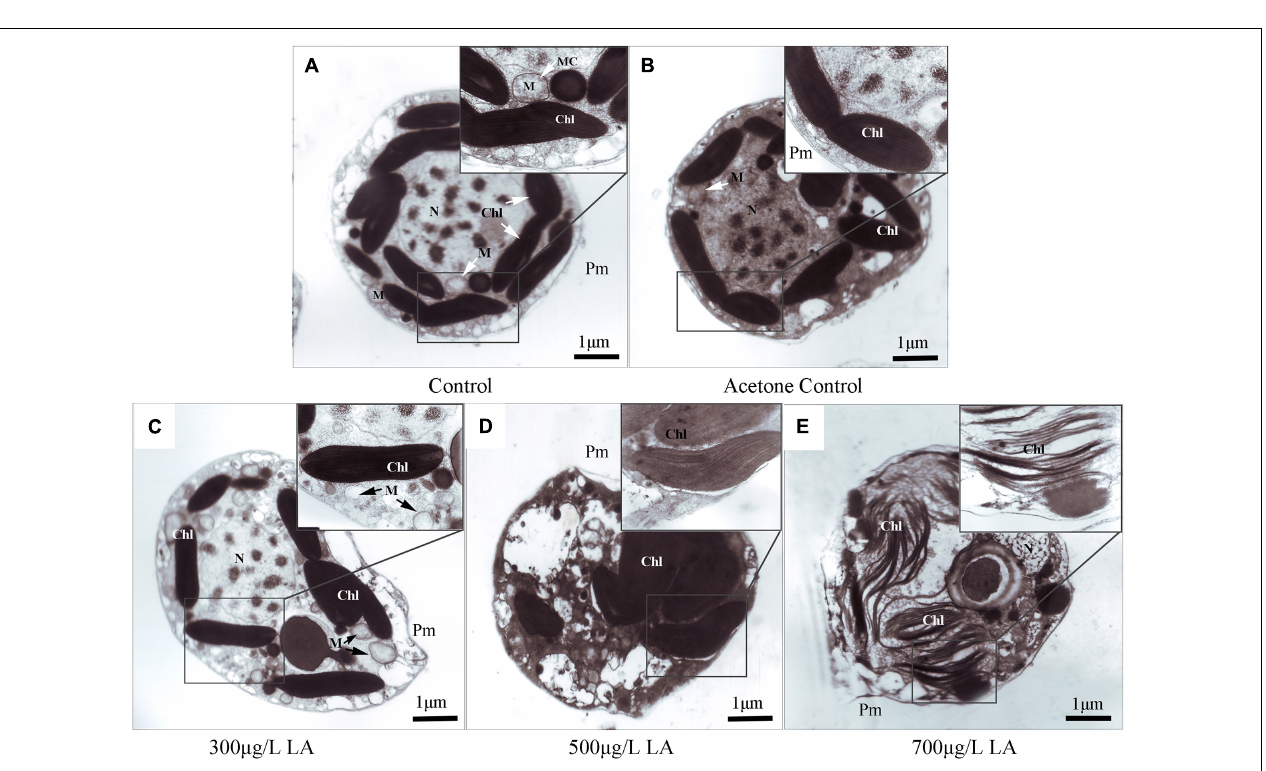
FIGURE 2 | Subcellular microstructure by TEM in the control and LA-treated groups of H. akashiwo: (A) control; (B) DMSO control; (C–E) different concentrations of LA-treated groups. Chl, M, MC, N, and Pm in each figure denote chloroplasts, mitochondria, mitochondrial cristae, nucleus and periplasm membranes,